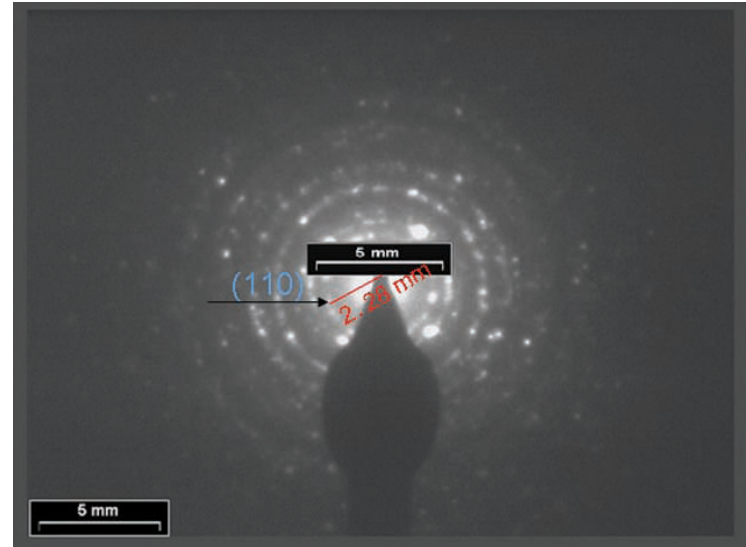
Figure 4. Electron diffraction pattern in conjunction with calculated planes. Inner halo ring corresponds well to the {110} planes of SnO